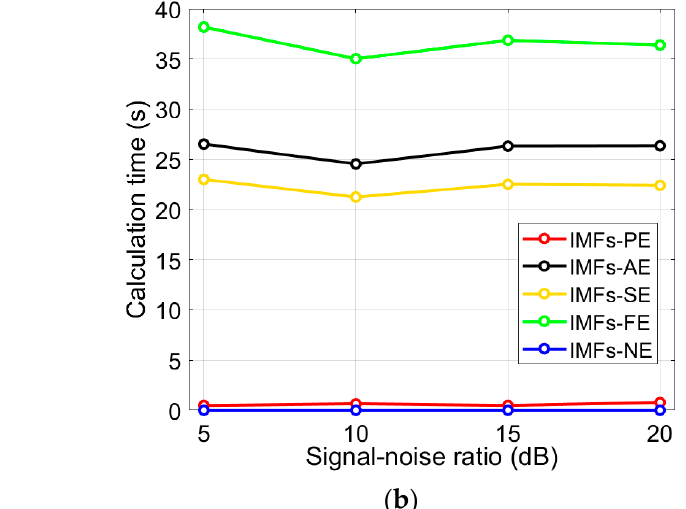
Table 6. Comparison with previous schemes.